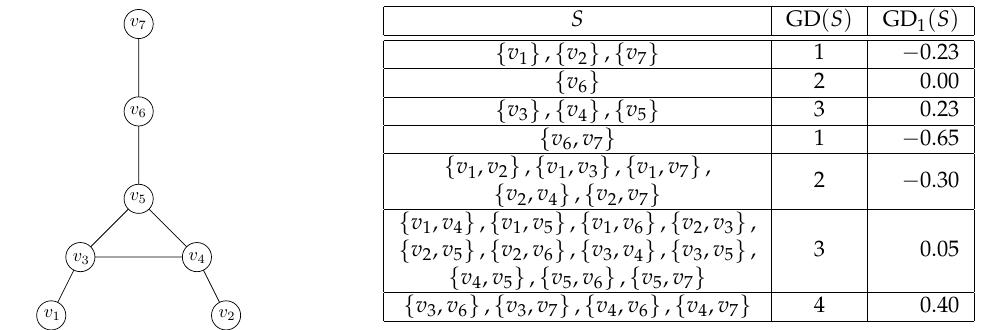
Figure 1. The Eiffel tower graph and the calculation of its group degree centralization for groups of sizes one and